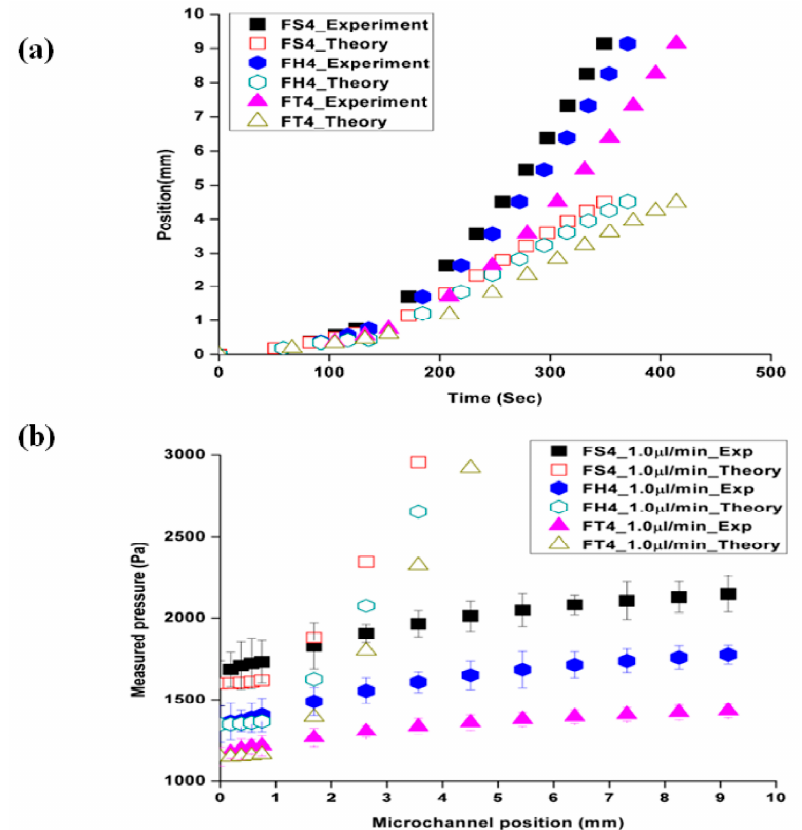
Figure 2. Typical data utilized for the flow analyses in the present work. Data shown are for flow through channels with three different shapes of obstacles at an imposed flow rate of 1 µL/min. ( a ) comparison of the experimental and theoretical position as a function of time and ( b ) developed pressure data as a function of the position.